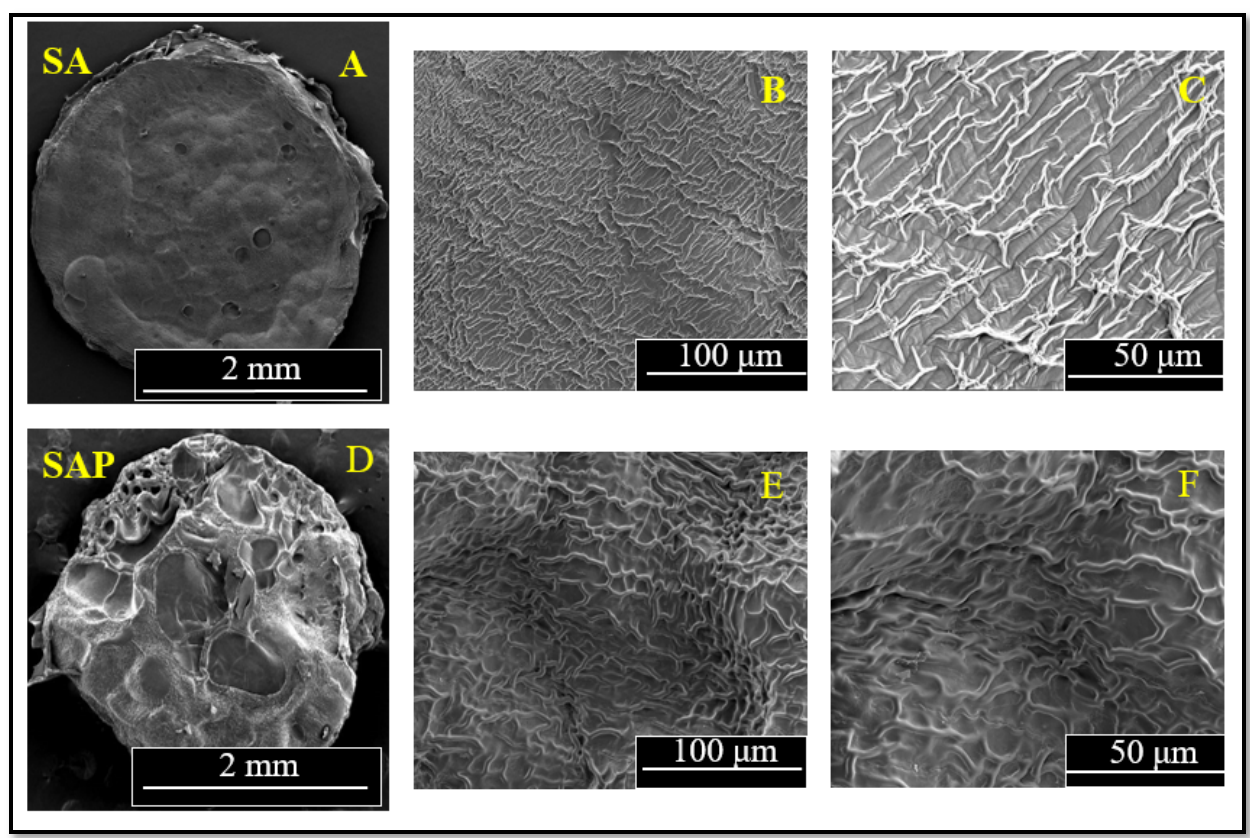
Figure 4. Scanning electron micrographs of sodium alginate hydrogel discs (SA) (micrographs ( A – C ), and of sodium alginate hydrogel discs modified with polyethyleneimine (SAP) (micrographs ( D – F ). Typical magnifications are: 50× for images ( A , D ), 1000× for images ( B , E ), and 2000× for images ( C , F ).